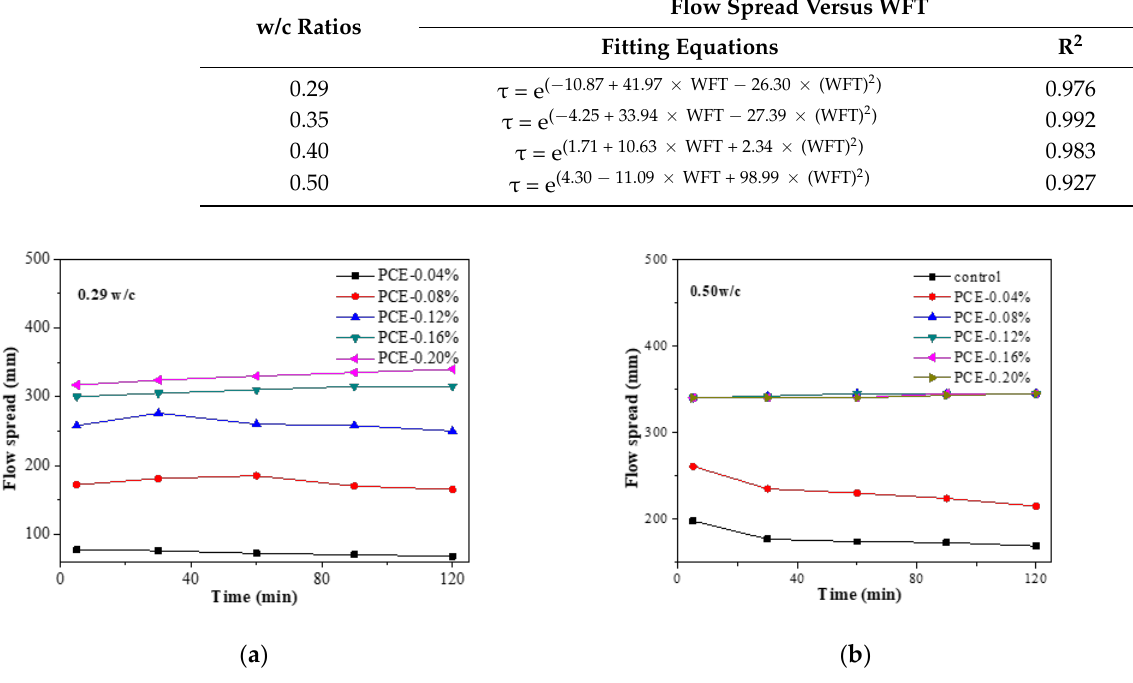
Figure 11. Time change of flow spread over 2 h. The dispersion function of superplasticizers is thought to work only after their ad- sorption on the surfaces of cement particles. To identify the dispersing capability of PCEs at different w/c ratios, it is useful to compare their adsorption behaviors. 0.00